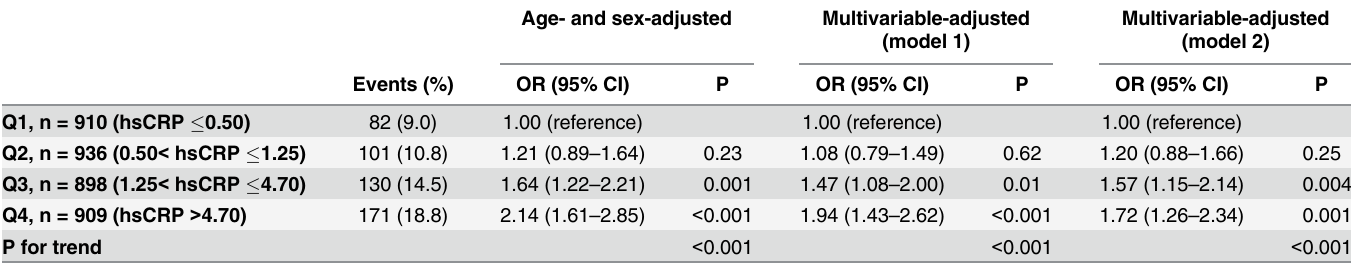
Table 3. Plasma hsCRP levels and neurological deterioration during hospitalization.